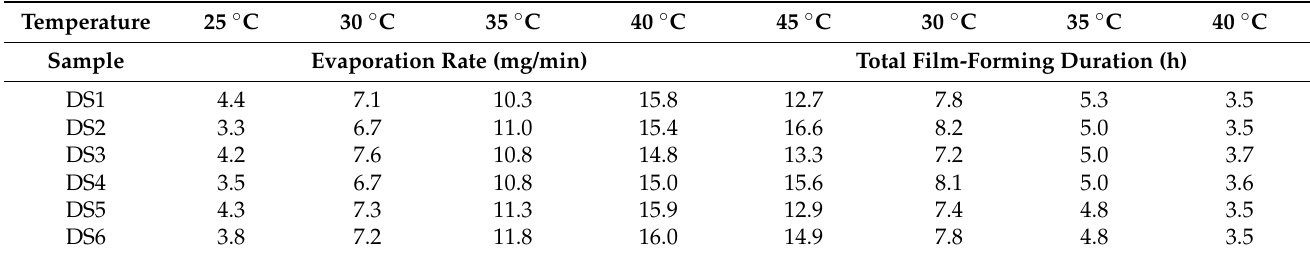
Table 2. Solvent evaporation rates for different compositions and temperatures.